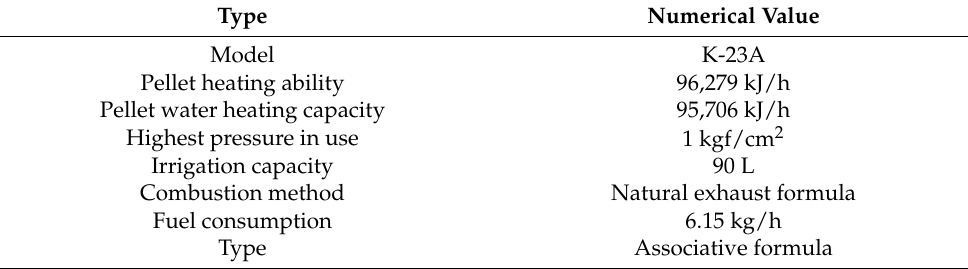
Table 2. Details of wood pellet boiler.